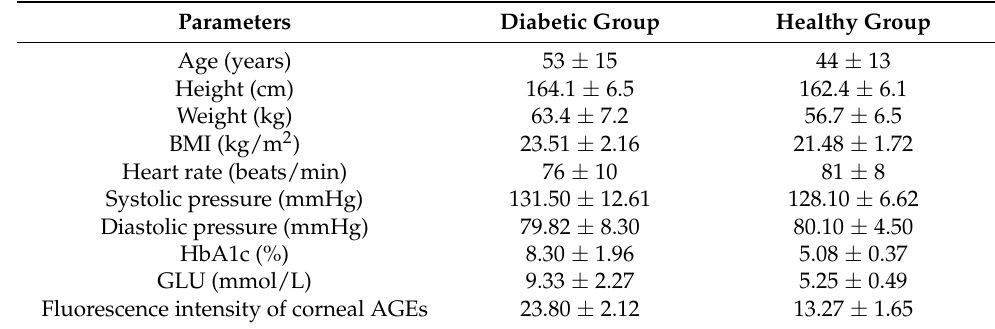
Table 1. Physiological parameters and data on the fluorescence intensity of corneal